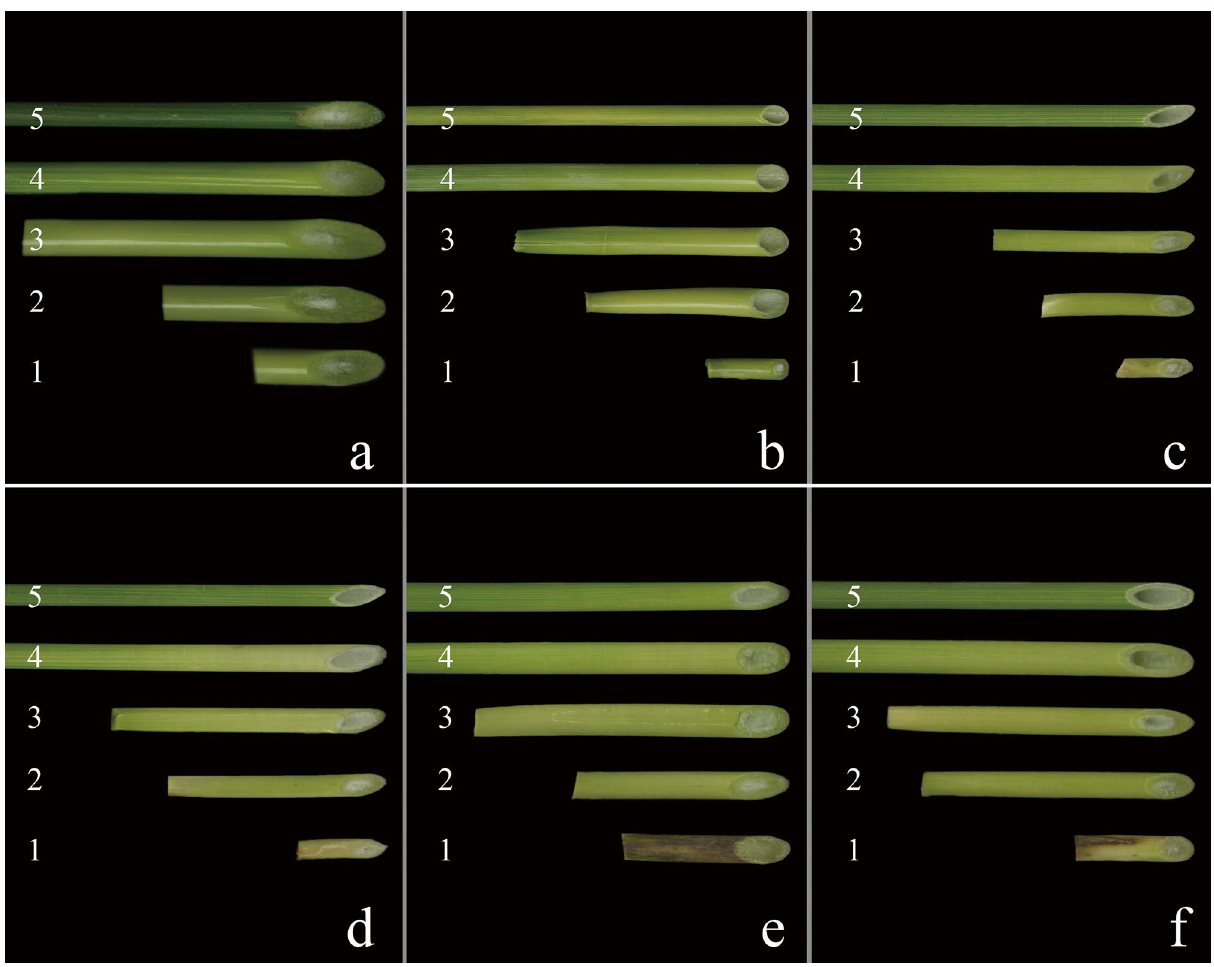
Figure 5. Stalk solidity of synthetic hexaploid wheat grown in the field. ( a ): Ma; ( b ): CS; ( c ): Syn-SAU-116; ( d ): Syn-SAU-117; ( e ): Syn-SAU-118 and ( f ): Syn-SAU-119. Numbers 1–5 indicate the first to fifth stem internodes (from the base to the top), respectively.